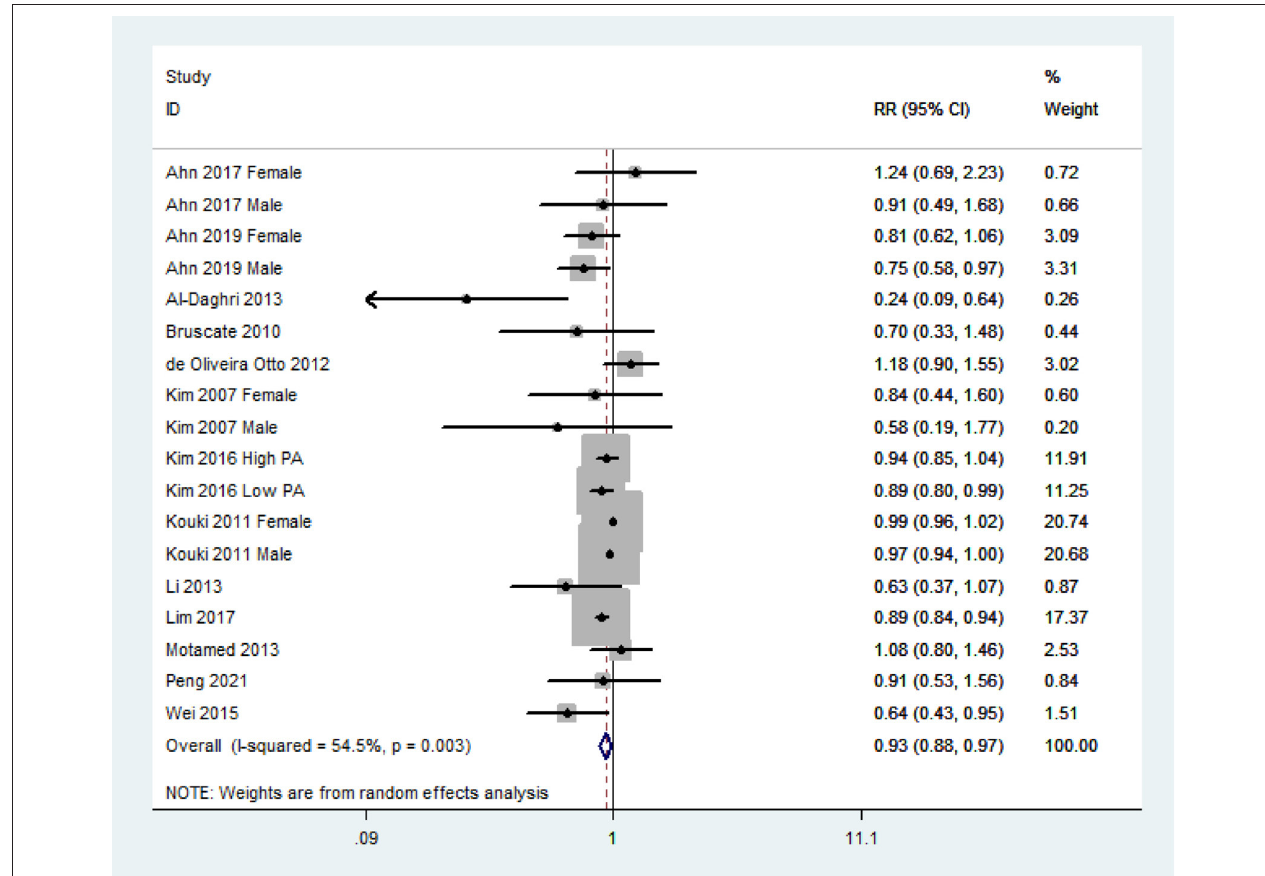
FIGURE 2 | Forest plot of meta-analysis. Overall multi-variable adjusted RR of MetS for the highest vs. lowest category of dietary vitamin C